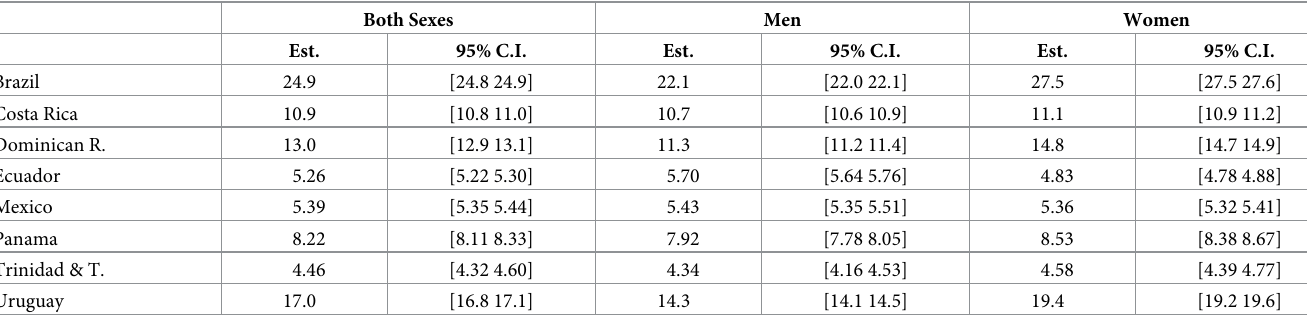
Table 2. Prevalence of disability by country and gender: Estimates. Both Sexes Men Women Est. 95% C.I. Est. 95% C.I. Est. 95%